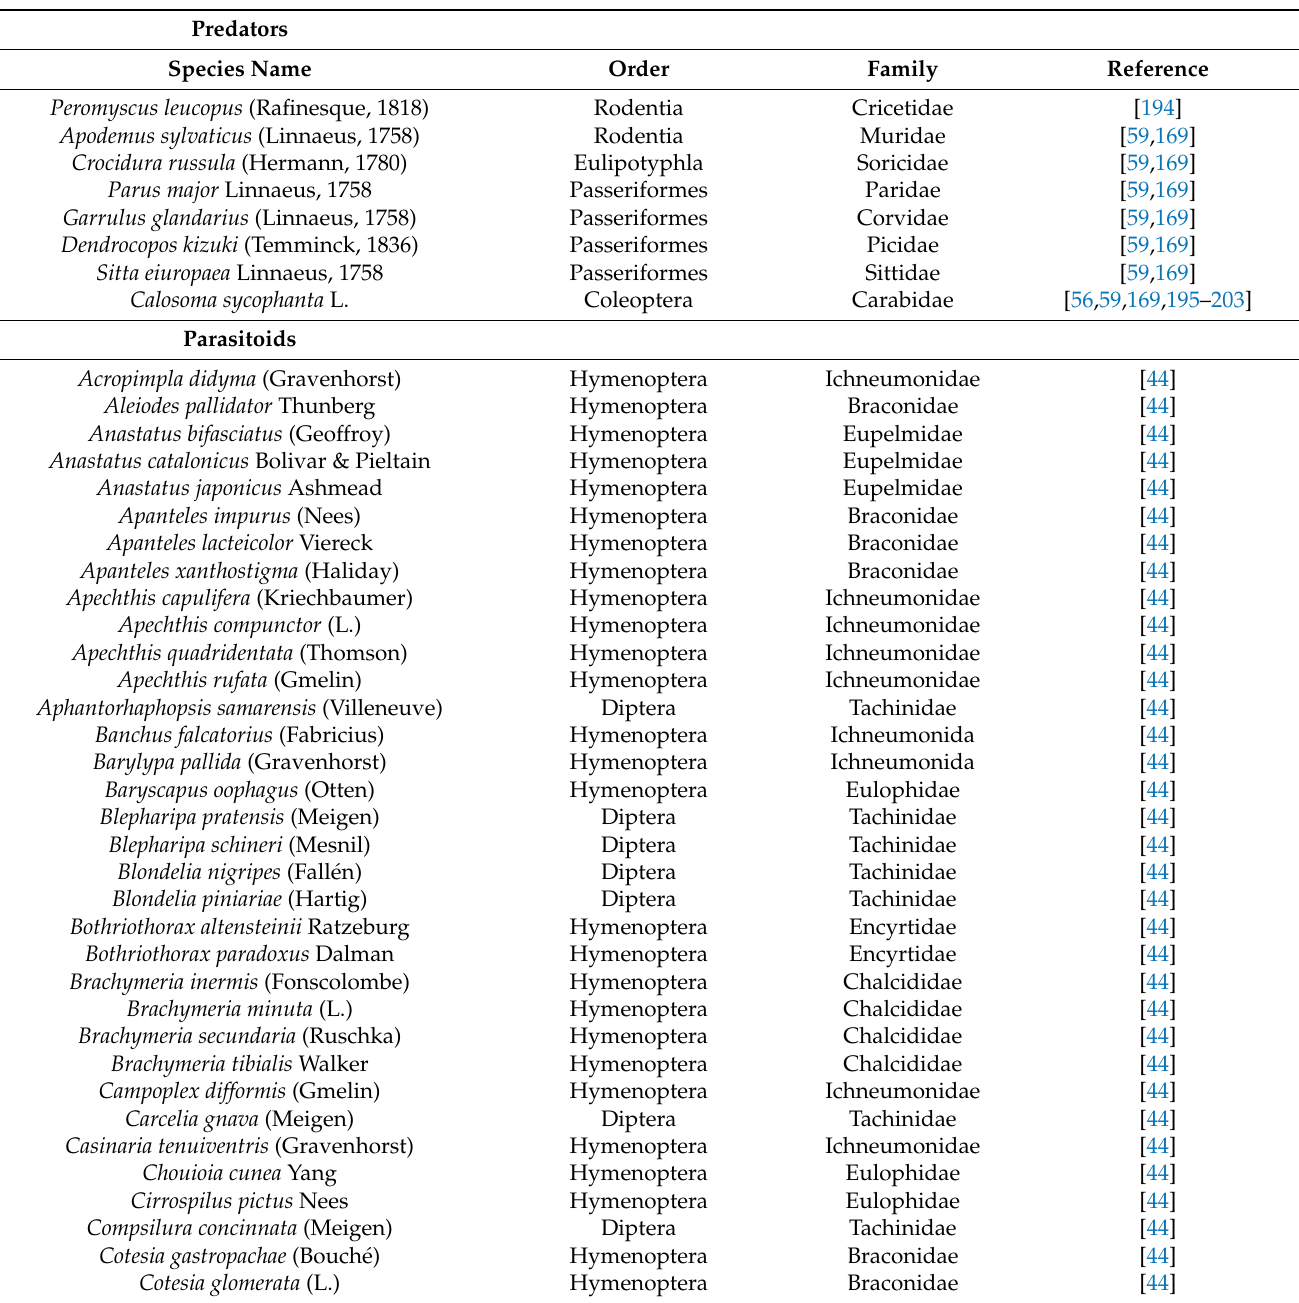
Table 2. Predators and parasitoids of Lymantria dispar